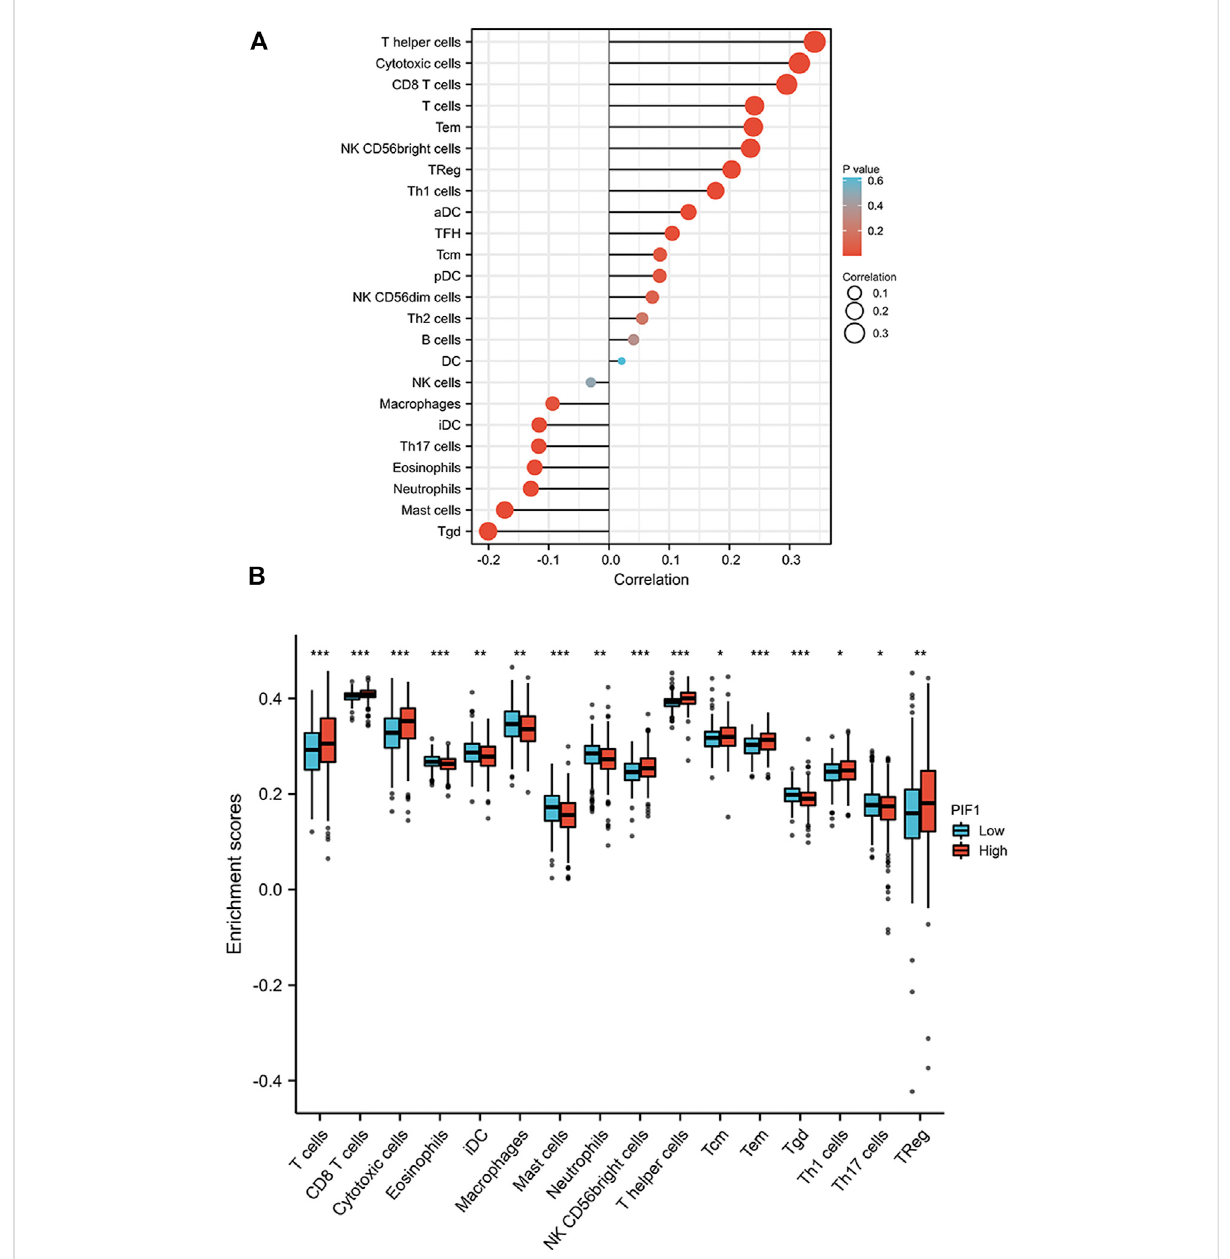
FIGURE 8 Correlations of PIF1 expression with immune in fi ltration level. (A) Relationships among the in fi ltration levels of 24 immune cell types and PIF1 expression pro fi les by Spearman ’ s analysis. (B) Comparison of the in fi ltration levels of the most correlated immune cells, including T-cell, CD8 + T-cell, cytotoxic cells, eosinophils, immature DCs (iDCs), macrophages, mast cells, neutrophils, NK CD56dim cells, T helper (Th) cells, Tcentral memory (Tcm), T effector memory (Tem), T gamma delta (Tgd), type 1 Th cells (Th1), type 17 Th cells (Th17), and regulatory T-cell